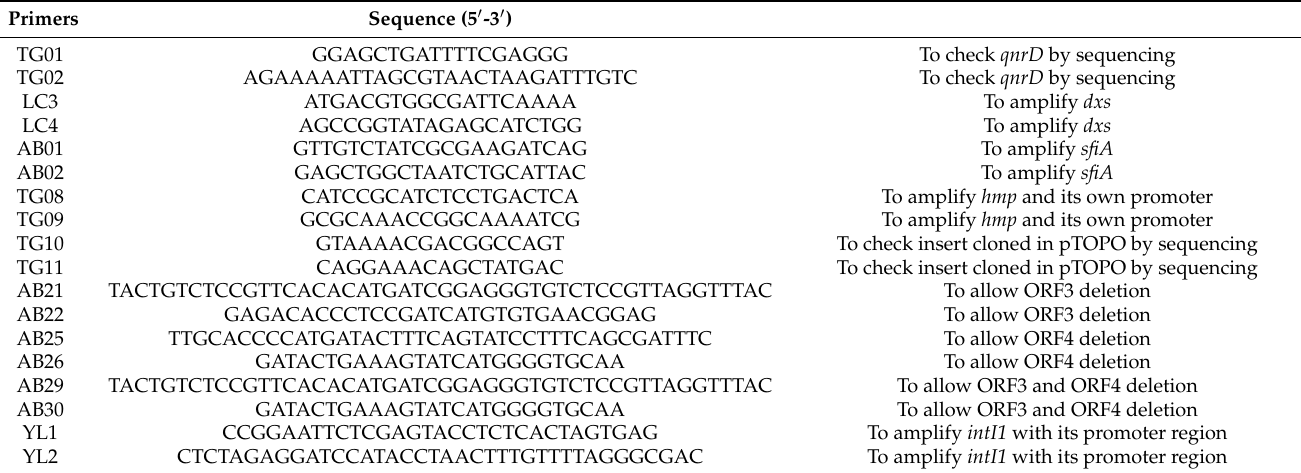
Table 2. Primers used for this